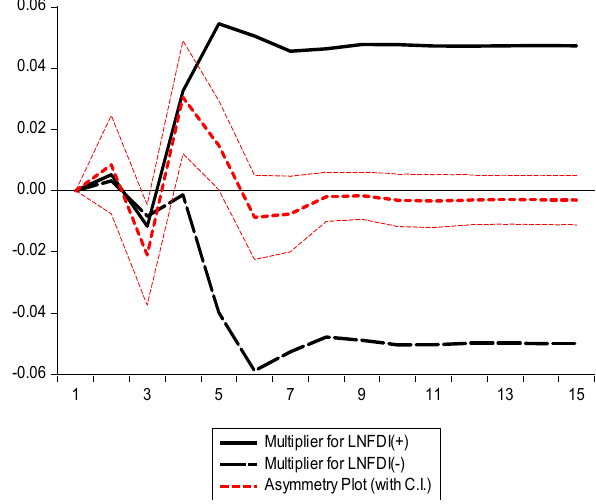
Figure 7. The dynamic multiplier for LNFDI.